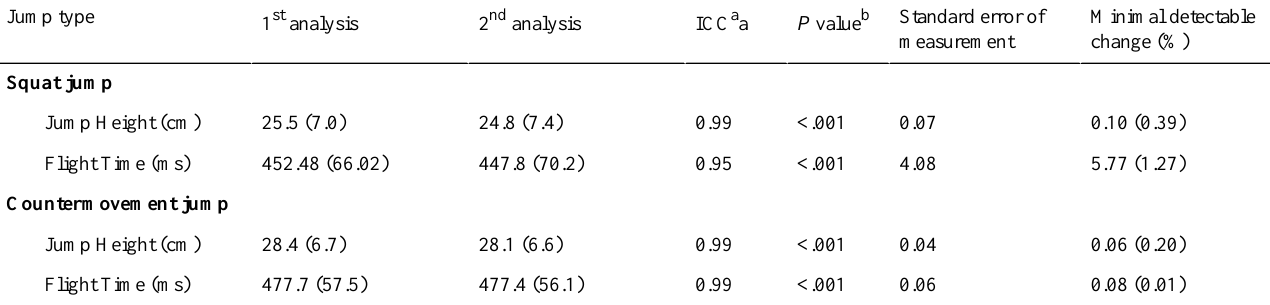
Table 3. Intraevaluator intraclass correlation coefficient of the MyJump2 in squat jump and countermovement jump.